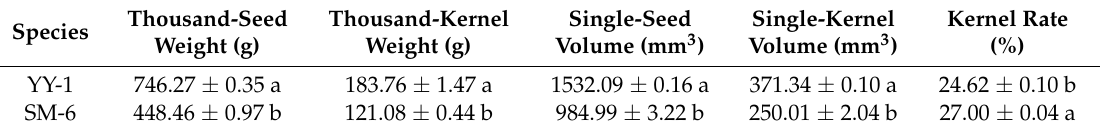
Table 2. Seed morphological characteristics of Amygdalus pedunculata Pall. (Mean ± Standard Deviation). Thousand-Seed Species Weight